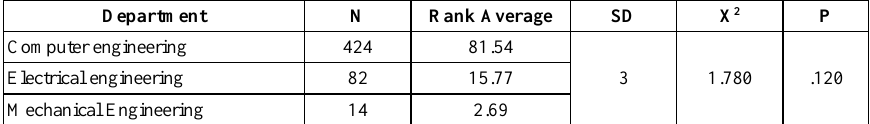
Table 8. Distance education situations according to the department